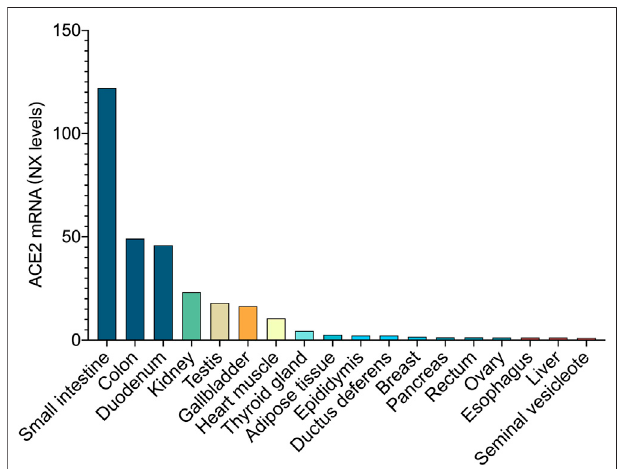
FIGURE 2 | ACE2 expression at the mRNA level.In combined data from HumanProteinAtlas,GenotypeTissueExpression,andFunctionalAnnotation of The Mammalian Genome, the top three tissues with the highest expression belong to the intestinal